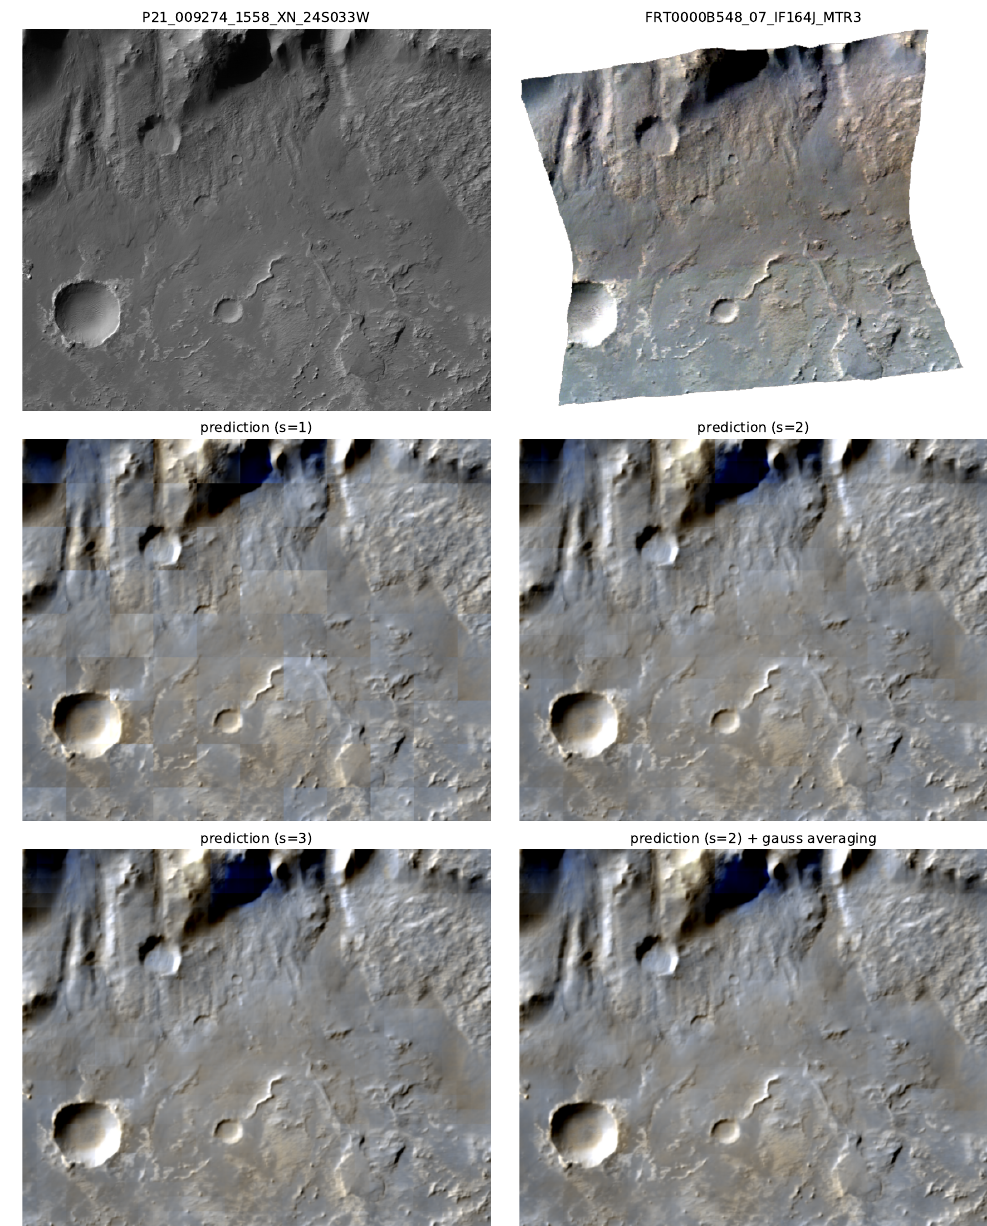
Figure 11. Full CTX-CRISM EVC image pair ( top row ) and model predictions with different strides and averaging techniques ( middle and bottom row